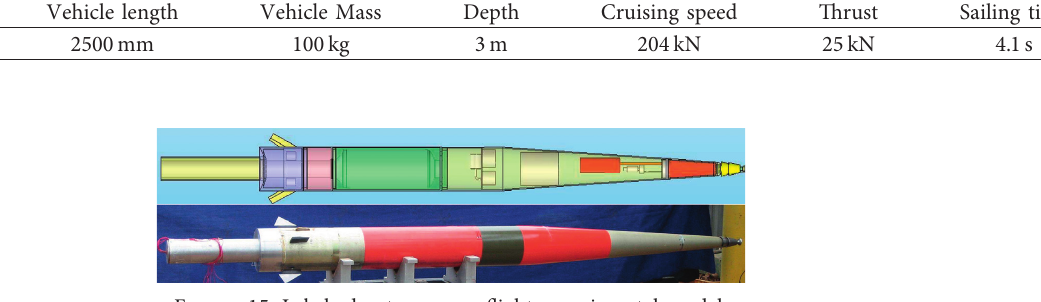
Figure 15: Lakebed autonomous flight experimental model.